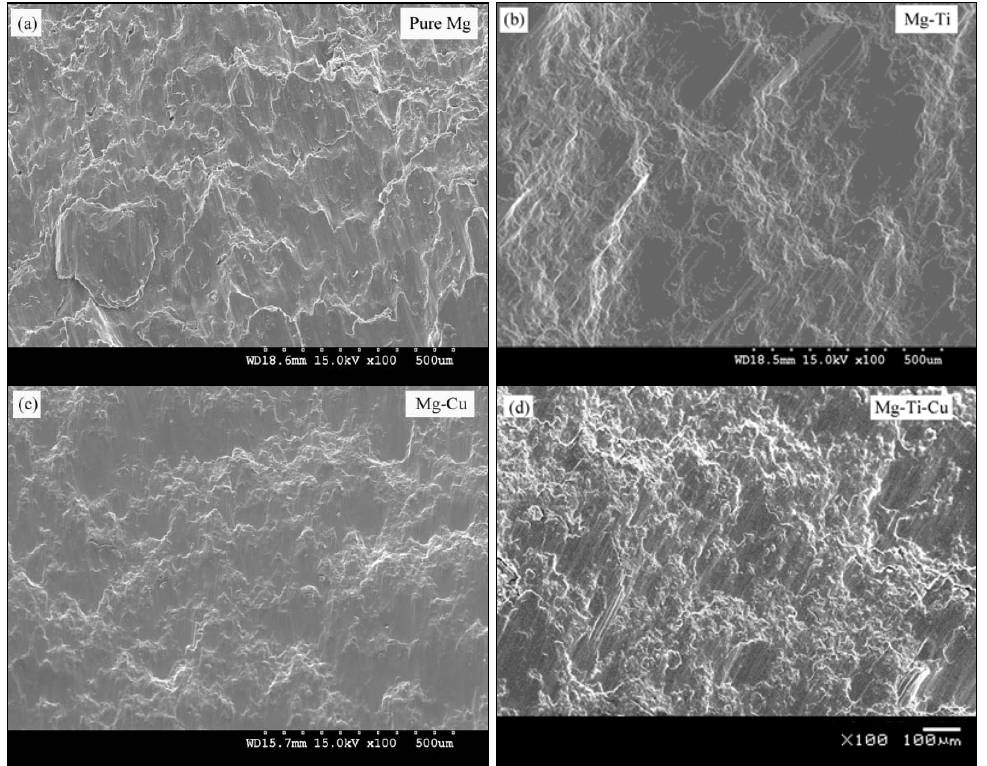
Figure 7. Fractographs of Mg-based materials under compression showing dominant shear failure. ( a ) Pure Mg; ( b ) Mg-Ti; ( c )Mg-Cu; ( d ) Mg-Ti-Cu and ( e ) Mg-(Ti + Cu)